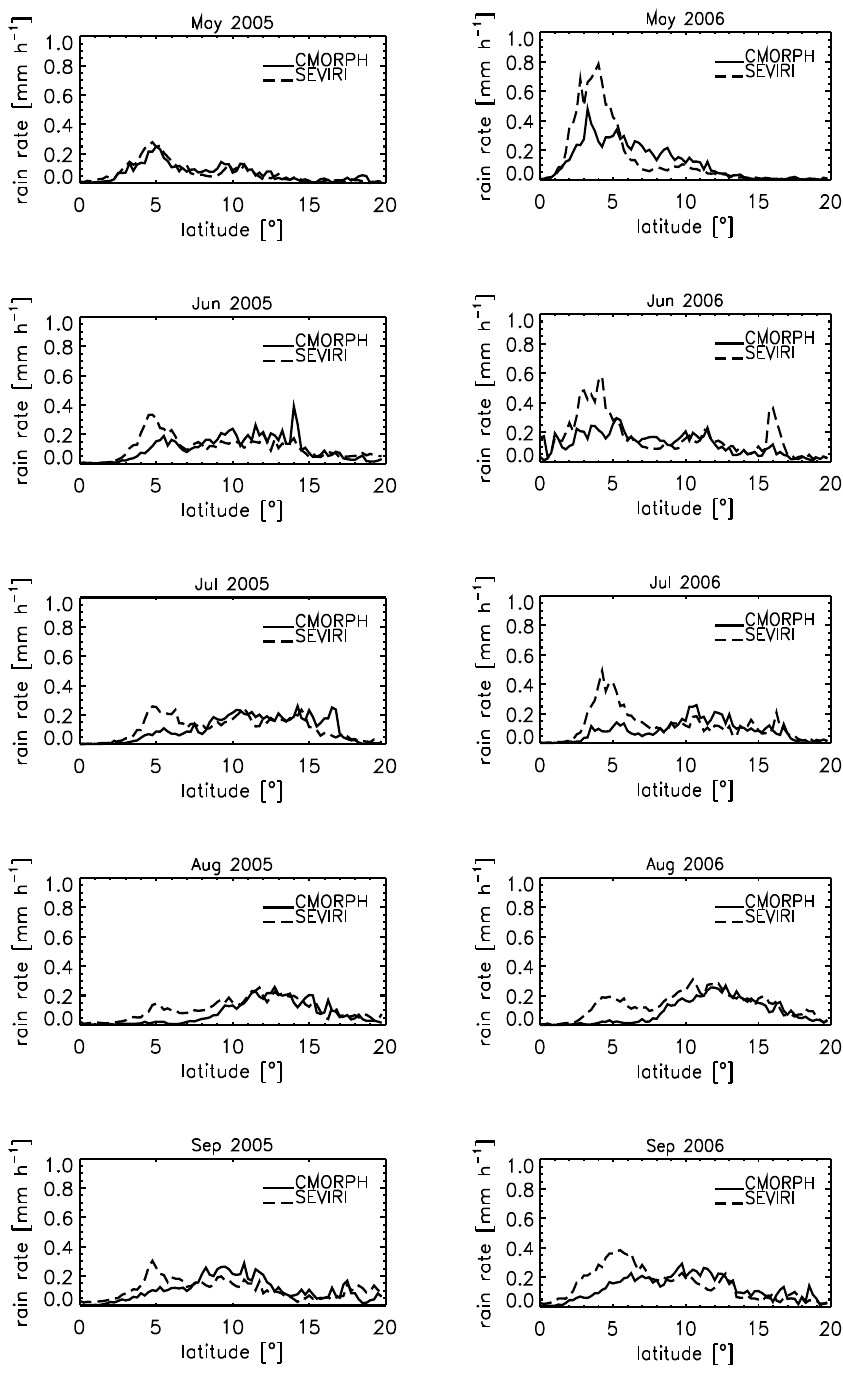
Fig. 7. Latitudinal cross section of monthly mean daytime conditional rain rate ( R> 0.05mmh − 1 ) from CMORPH (solid line) and CPP-PP (dashed line) for (left) May–September 2005 and (right) May–September 2006. Both datasets are at 0.25 ◦ × 0.25 ◦ resolution. savannah region, Fig. 9, middle column). In addition, as for the rain forest region, for almost all months CPP-PP has lower absolute rain rate values compared to CMORPH.